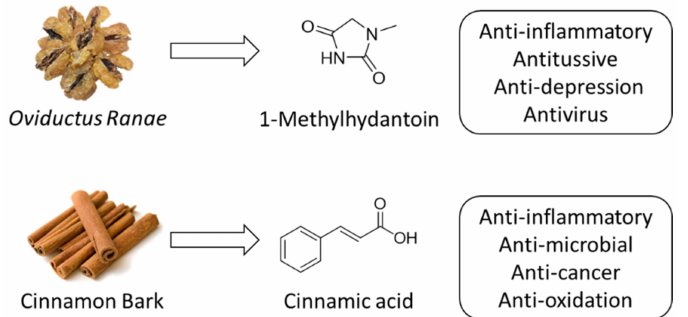
Figure 1. The 1-methylhydantoin was isolated from a traditional Chinese medicine, Oviductus Ranae . Trans -Cinnamic acid is a natural product that can be isolated from cinnamon